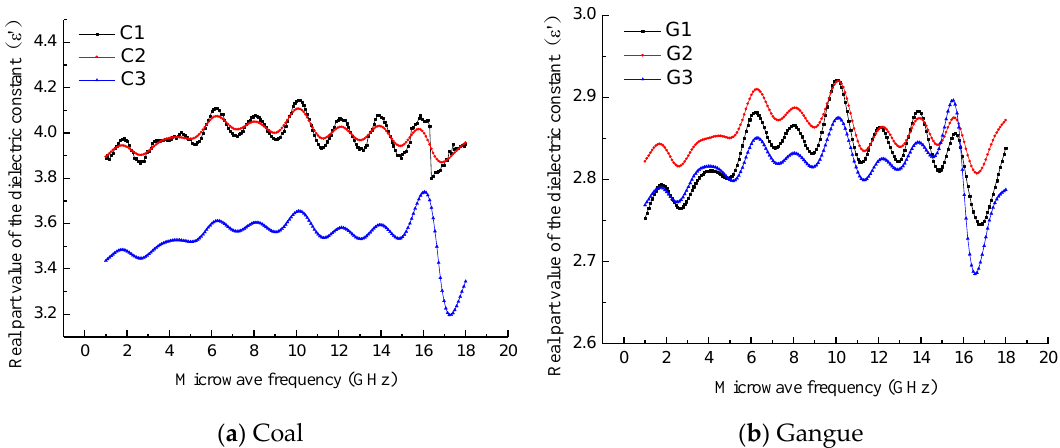
Figure 11. Change of dielectric constant real part for coal and gangue samples under different particle sizes.